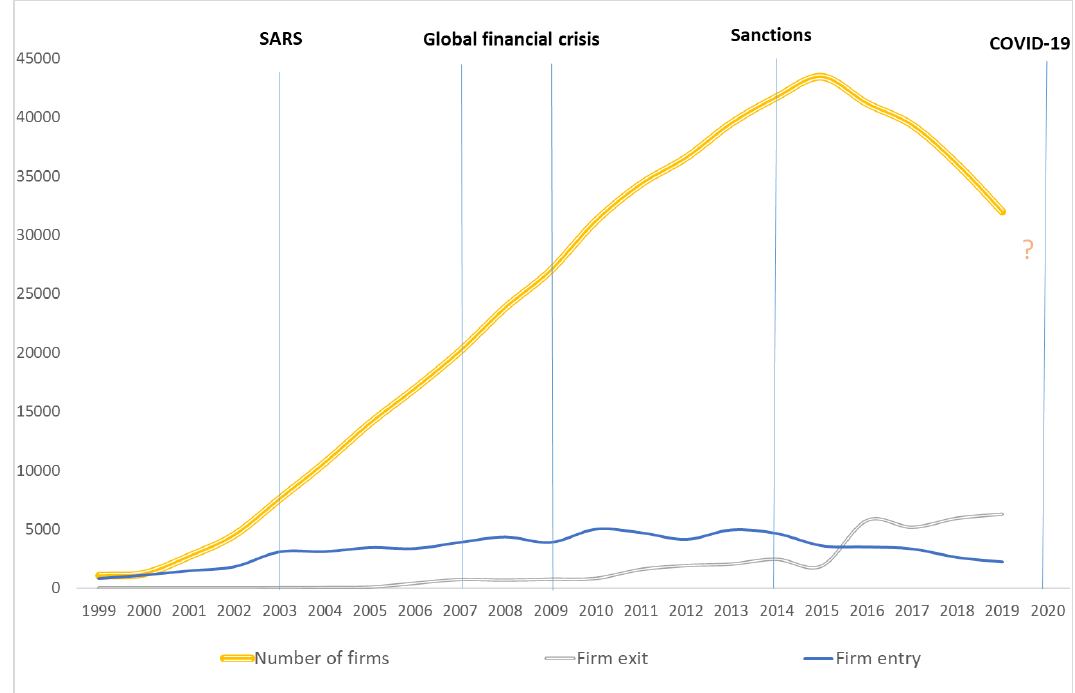
Figure 2. The dynamics of the Russian tourism industry (data from Industrial register).